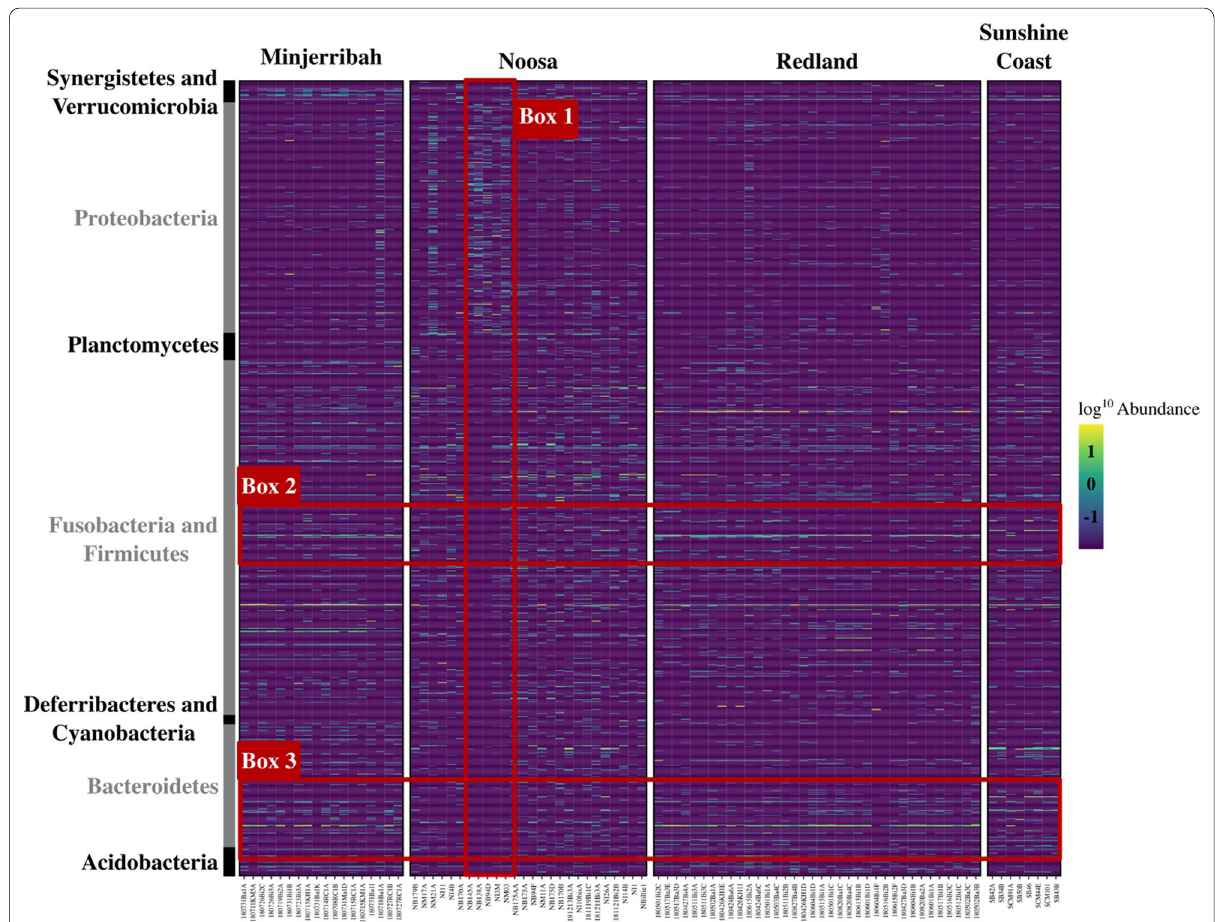
Fig. 7 Relative abundance of koala gut microbial species across locations. Rows represent ASVs ( n and the values in the heatmap represent logged relative microbial abundance, with green representing greater relative abundance. Black and grey shading in the left sidebar indicates the phylum level taxonomic assignment of each ASV (ASVs classified to 11 bacterial phyla). Box 1: five individuals within Noosa show an abundance of the phylum Proteobacteria , whilst showing a depletion in most other phyla. Box 2: ASVs taxonomically assigned to phylum Firmicutes are more abundantly represented in samples from Minjerribah, Redland and Sunshine Coast compared to samples from Noosa. Box 3: ASVs taxonomically assigned to the phylum Bacteroidetes were less abundantly represented in Noosa and Sunshine Coast